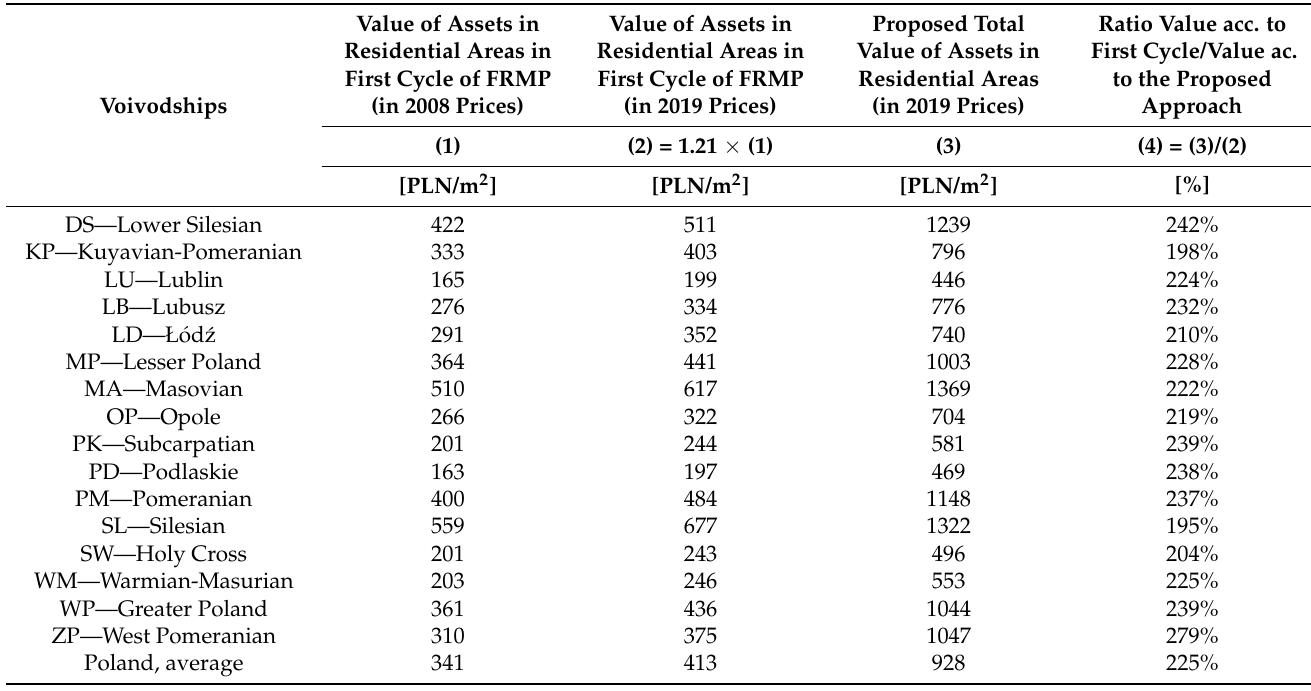
Table 10. Value of assets in residential areas in 16